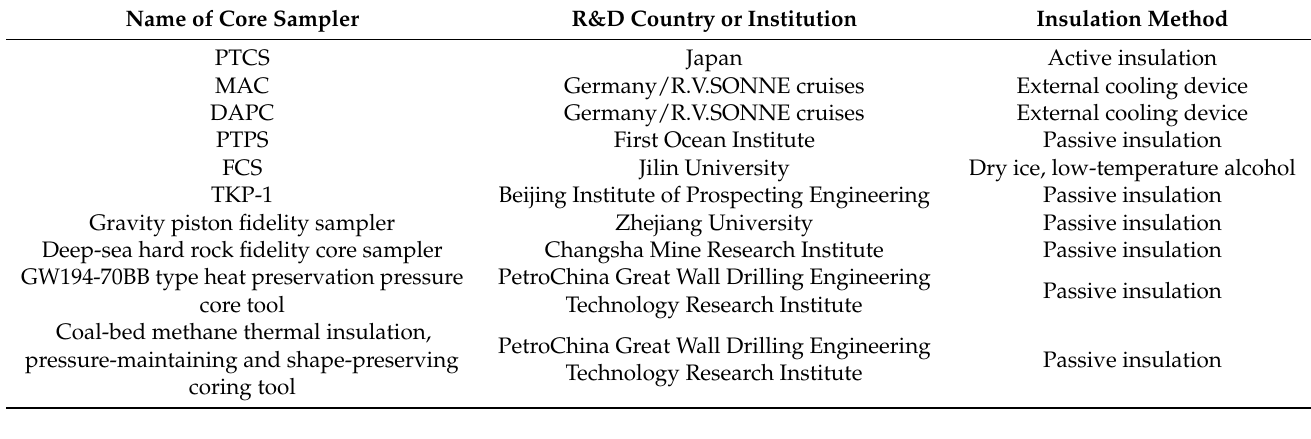
Table 1. Main thermal insulation method of core remover.